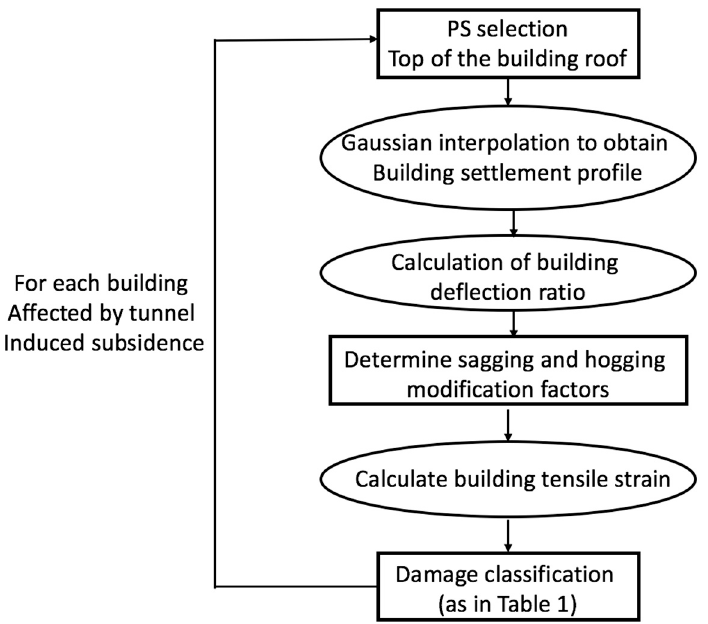
Figure 7. Schematic representation of the proposed method of the T-InSAR/relative stiffness method.